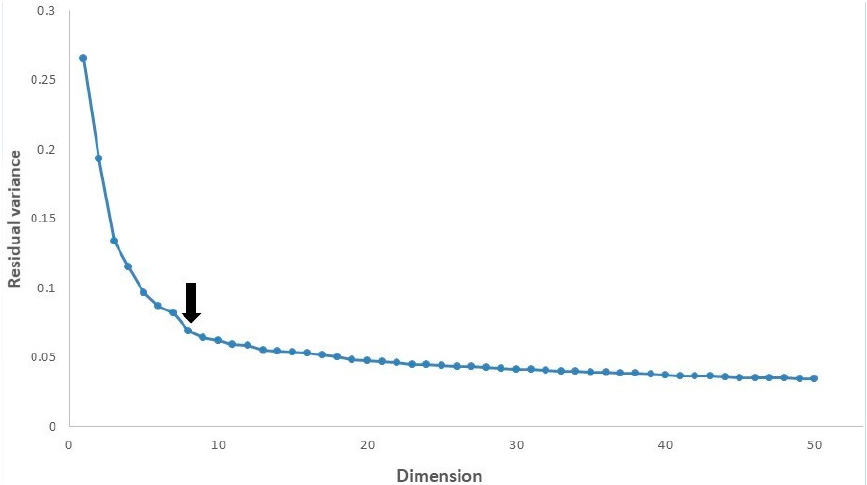
Figure 5. The residual variance of ISOMAP in our data.